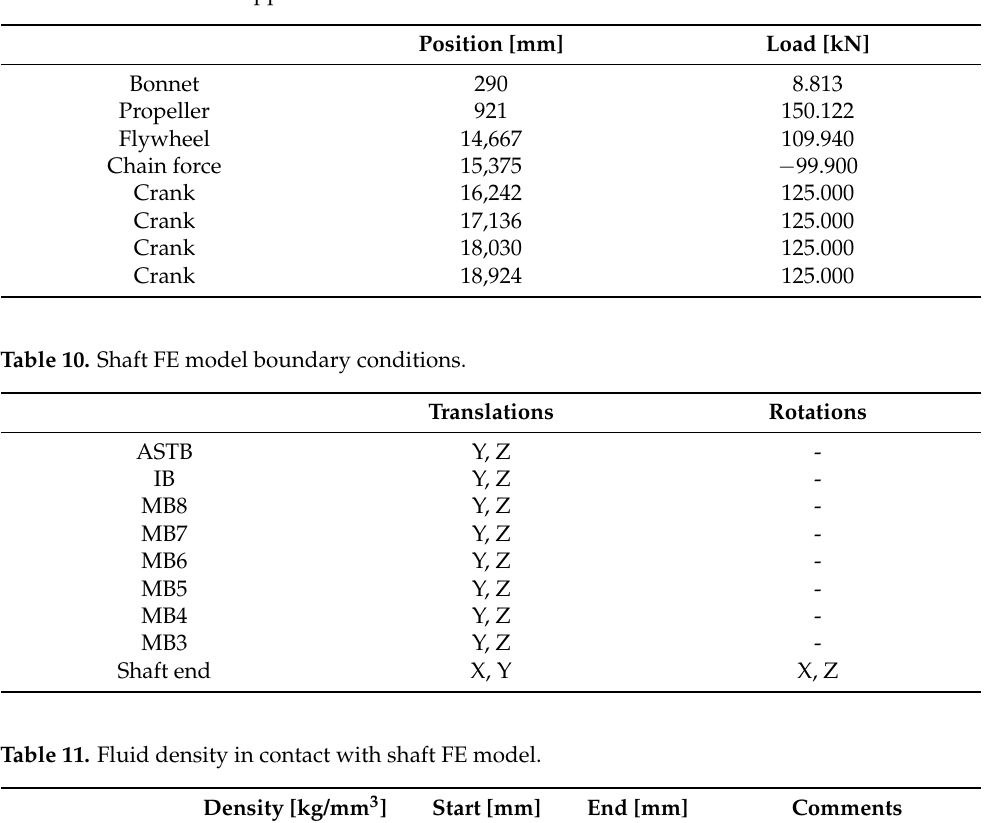
Table 9. Shaft FE model applied loads.